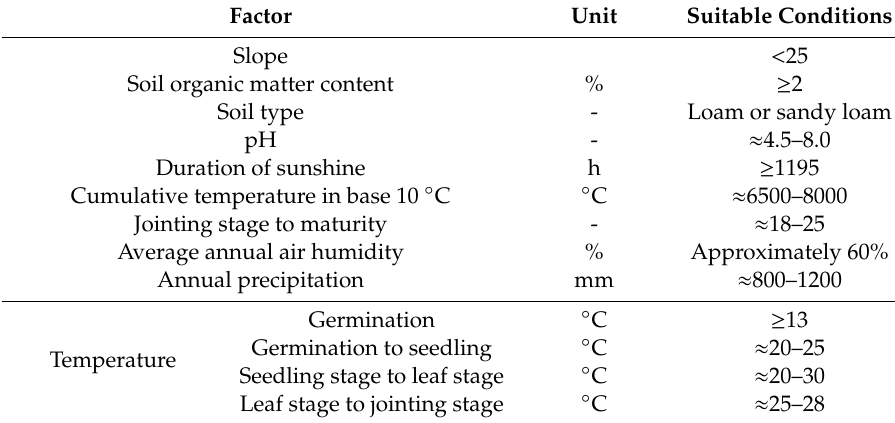
Table 1. Sugarcane growth conditions based on the relevant literature [23].